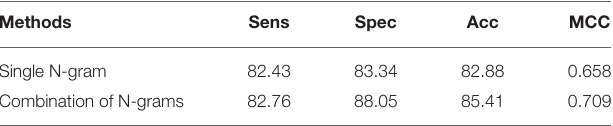
TABLE 2 | Comparison between single N-gram and combination of continuous N-grams.